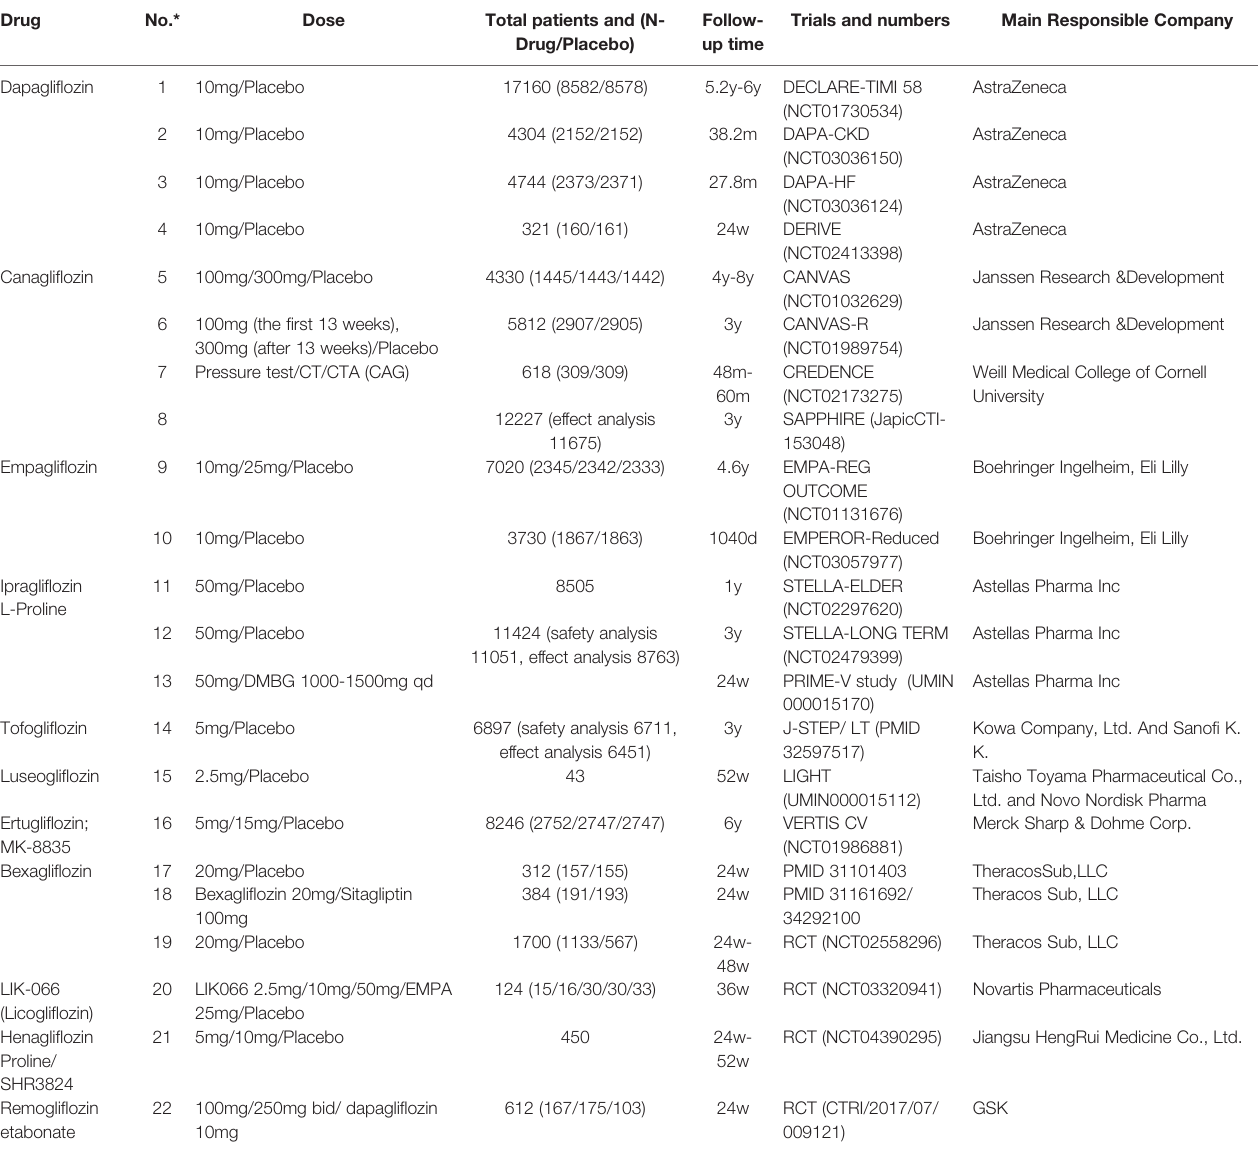
* Table 1 and Table 2 correspondbycolumnof No.